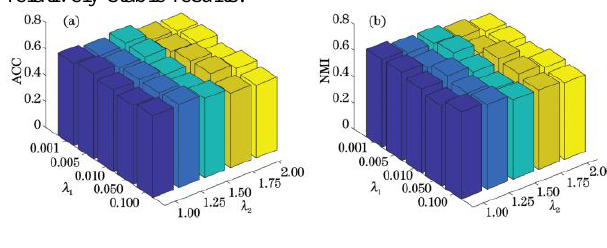
Figure 6. Effect of different combinations of  on the ACC and NMI on the  , and parameters 1 2 Fashion-MNIST dataset.(a) Effect on ACC; (b) Effect on